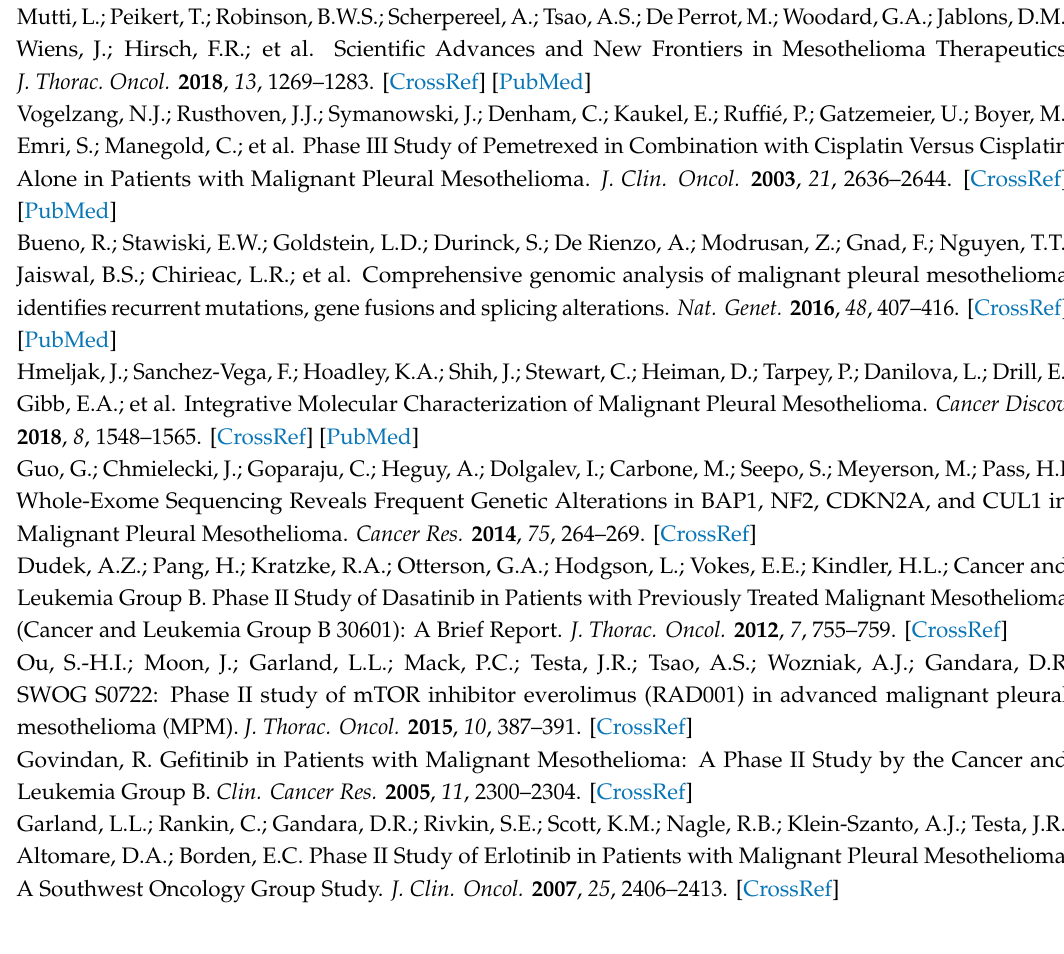
Figure S1: Weighted gene correlation network analysis (WGCNA) reveal gene modules linked with major genetic alterations in MPM; Figure S2: Pathway enrichment analyses of the genes significantly correlated with CDKN2A / 2B loss; Figure S3: MPM has a high extracellular matrix (ECM) gene signature; Figure S4: Pathway enrichment analyses of the genes significantly correlated with NF2 alterations; Figure S5: Pathway enrichment analyses of the genes significantly correlated with TP53 mutations; Figure S6: Mutually exclusive and co-occurring analyses of STED2 and EGFR family genes across TCGA pan-cancer solid tumors; Figure S7: LATS2-altered MPM tumors enrich for the immune-regulatory signature; Figure S8: Tumor suppressor genes (TSGs)-guided precision oncology in